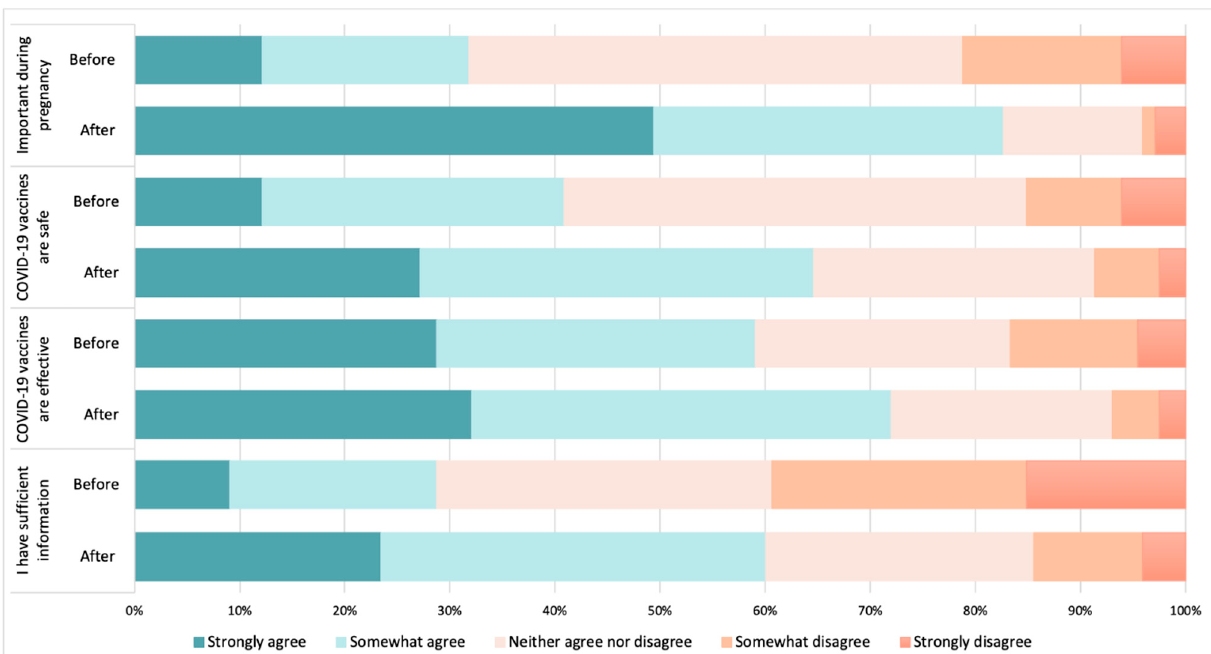
Figure 6. Views and perceptions of HCWs towards COVID-19 vaccination during pregnancy and other maternal vaccinations, before and after COVID-19 maternal vaccination national guidelines in May 2021.